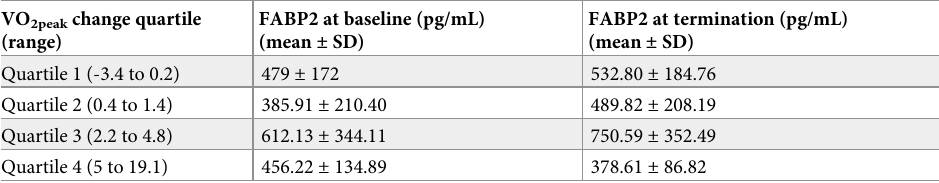
Table 2. Baseline and termination values of FABP2 for each quartile of VO 2peak change. VO 2peak change quartile